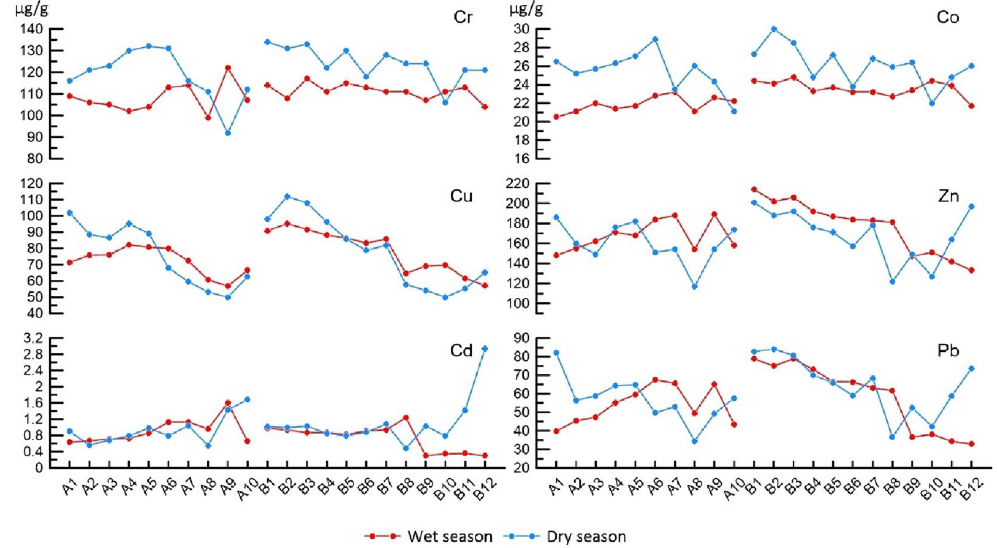
Figure 2. Heavy metals contents in the sediments from cruises A and B in the ED Lake (μg/g). A1 to A10 belongs to cruise A, while B1 to B12 belongs to cruise B. Red solid dots represent samples collected in the wet season, and blue solid dots represent samples collected in the dry